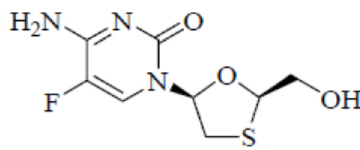
Figure 1. Molecular structure of emtricitabine (ECT) (molar mass: 247.24 g mol − 1 ). It is a synthetic nucleoside analog which is active against human immunodeficiency virus type I (HIV-I) reverse transcriptase [2,3]. It is used alone or in combination with other antiviral drugs in the treatment of HIV-I-infected patients [3–5]. ECT is commercially available as capsules or oral solutions by the brand name of Emtriva ® for the treatment of HIV-I-infected patients [2,5]. It is reported as freely soluble in water at T = 298.2 K [2]. ECT is highly water-soluble drug and hence rapidly and extensively absorbed follow- ing oral administration of capsules or oral solutions [5]. The absolute bioavailability